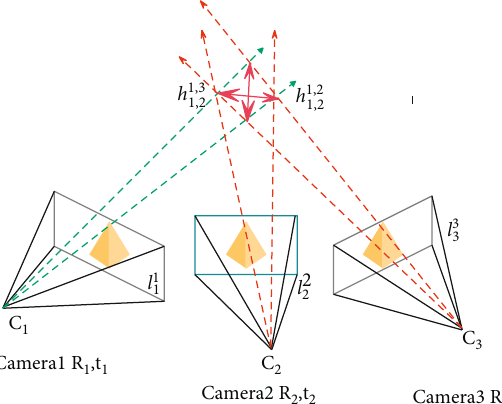
Figure 7: Pairwise incorrect matching results in a spatially in- consistent three-dimensional line segment hypothesis.